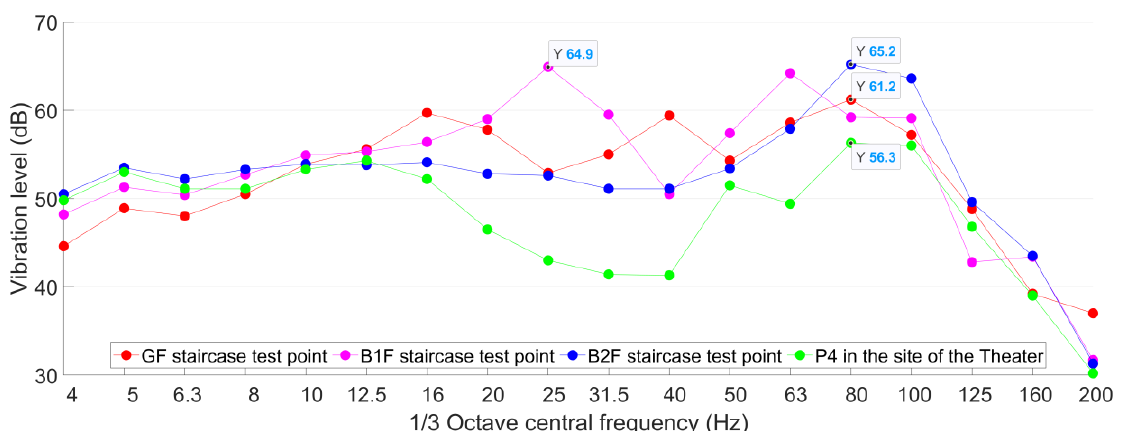
Figure 17. The1/3 octave frequency division vibration acceleration levels of the staircase test points in the shopping center compared with P4 in the site of the theater.